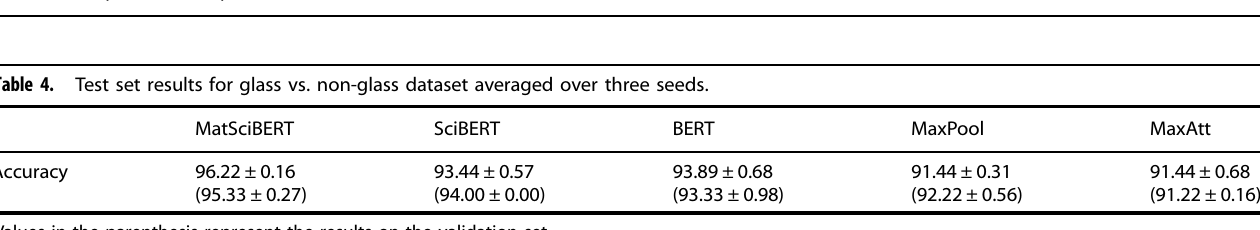
Values in the parenthesis represent the results on the validation